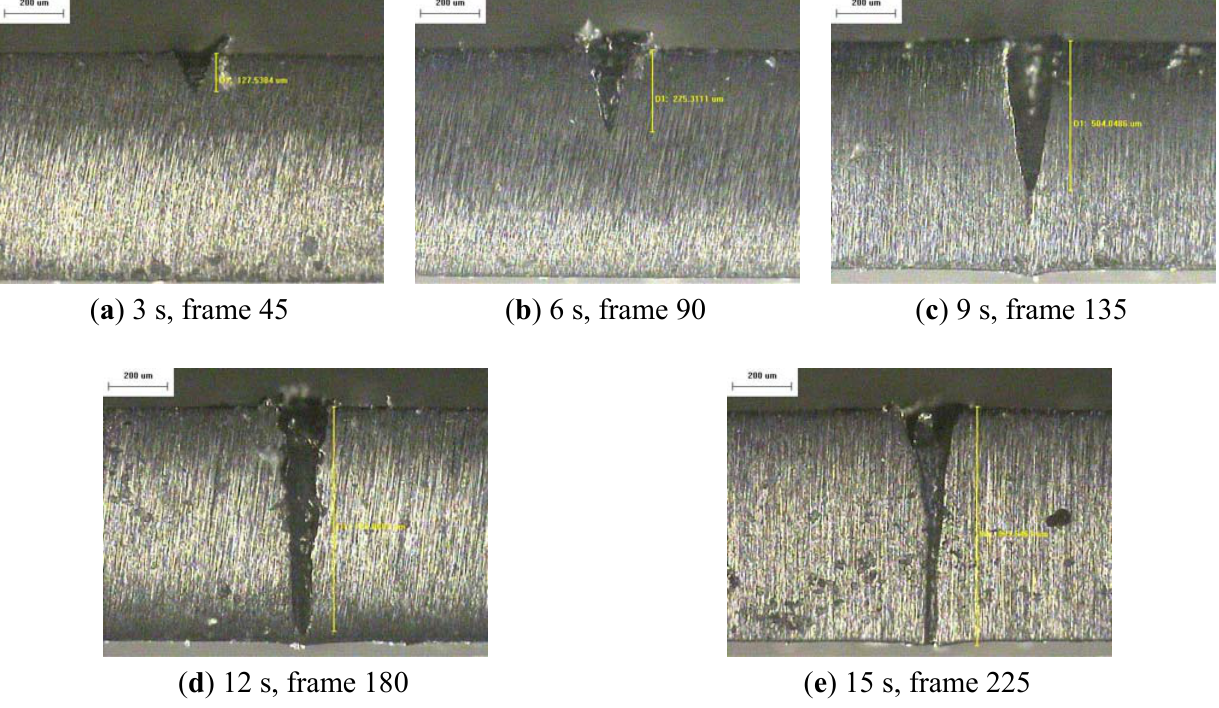
Figure 10. Workpiece (SS 420) profile images at different process times (radiation energy is 200 mJ): ( a – e ) 50×.